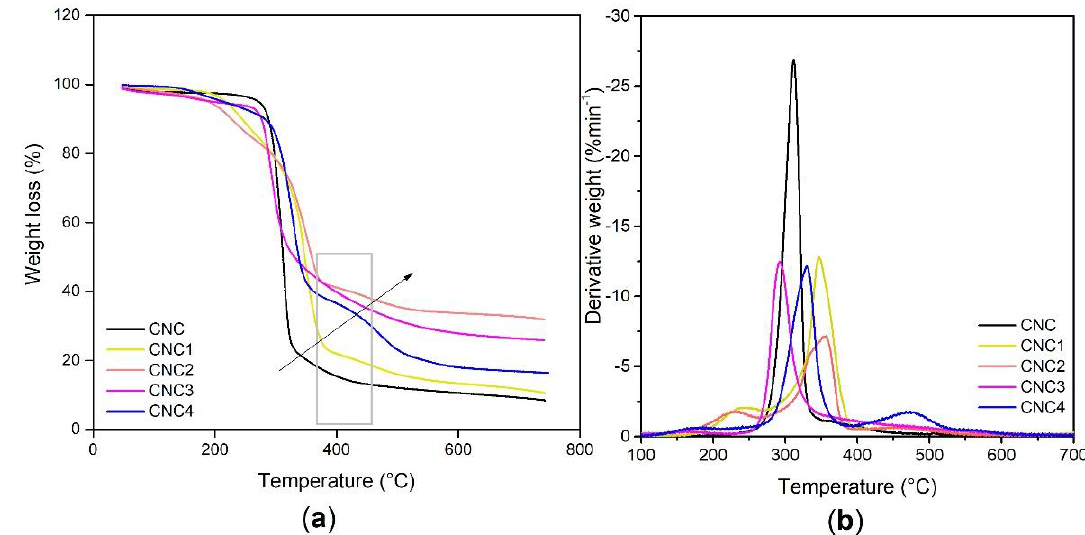
Figure 3. Thermogravimetric curves of native and grafted CNCs ( a ); derivative thermogravimetric curves ( b